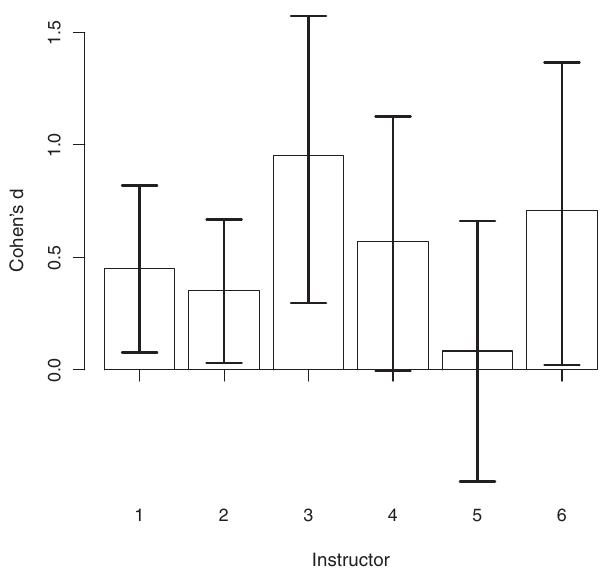
FIG. 2. Plot of Cohen’s d by instructor. Error bars reflect the 95% confidence interval on the